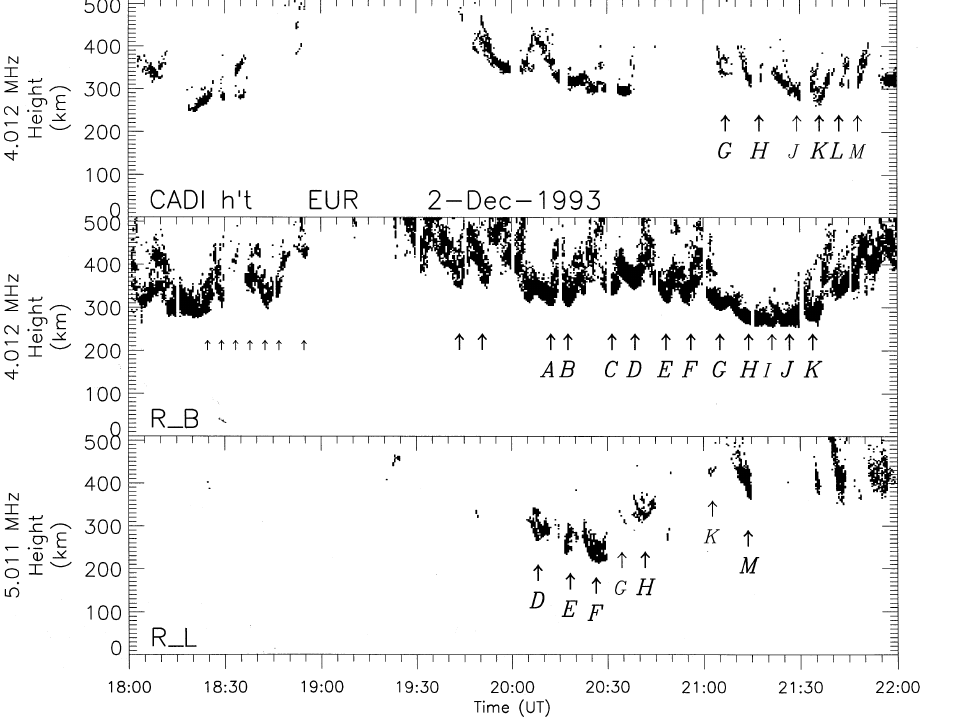
Fig. 17. The fixed frequency ionograms (virtual height versus time) obtained in Rabbit Lake, Resolute Bay and Eureka. The arrows in the top panel indicate times when optical (630-nm) patches passed overhead in Eu- reka (Fig. 18). The thick arrows in the bottom two panels show polar patches drifting over Rabbit Lake and Resolute Bay that were identified with SuperDARN backscatter bands. The small arrows indicate the short-period structure imposed on the iono- sphere by FLRs